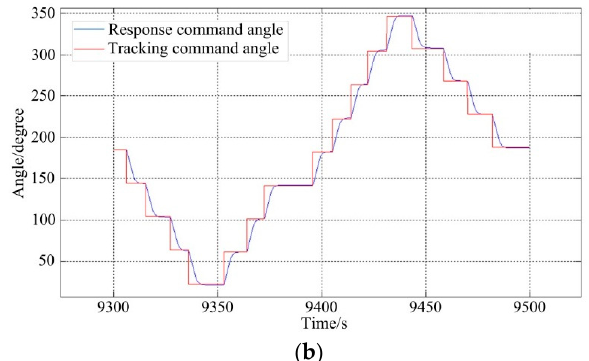
Figure 13. The tracking results of angle position under static testing: ( a ) the pitch system; ( b ) the azimuth system.